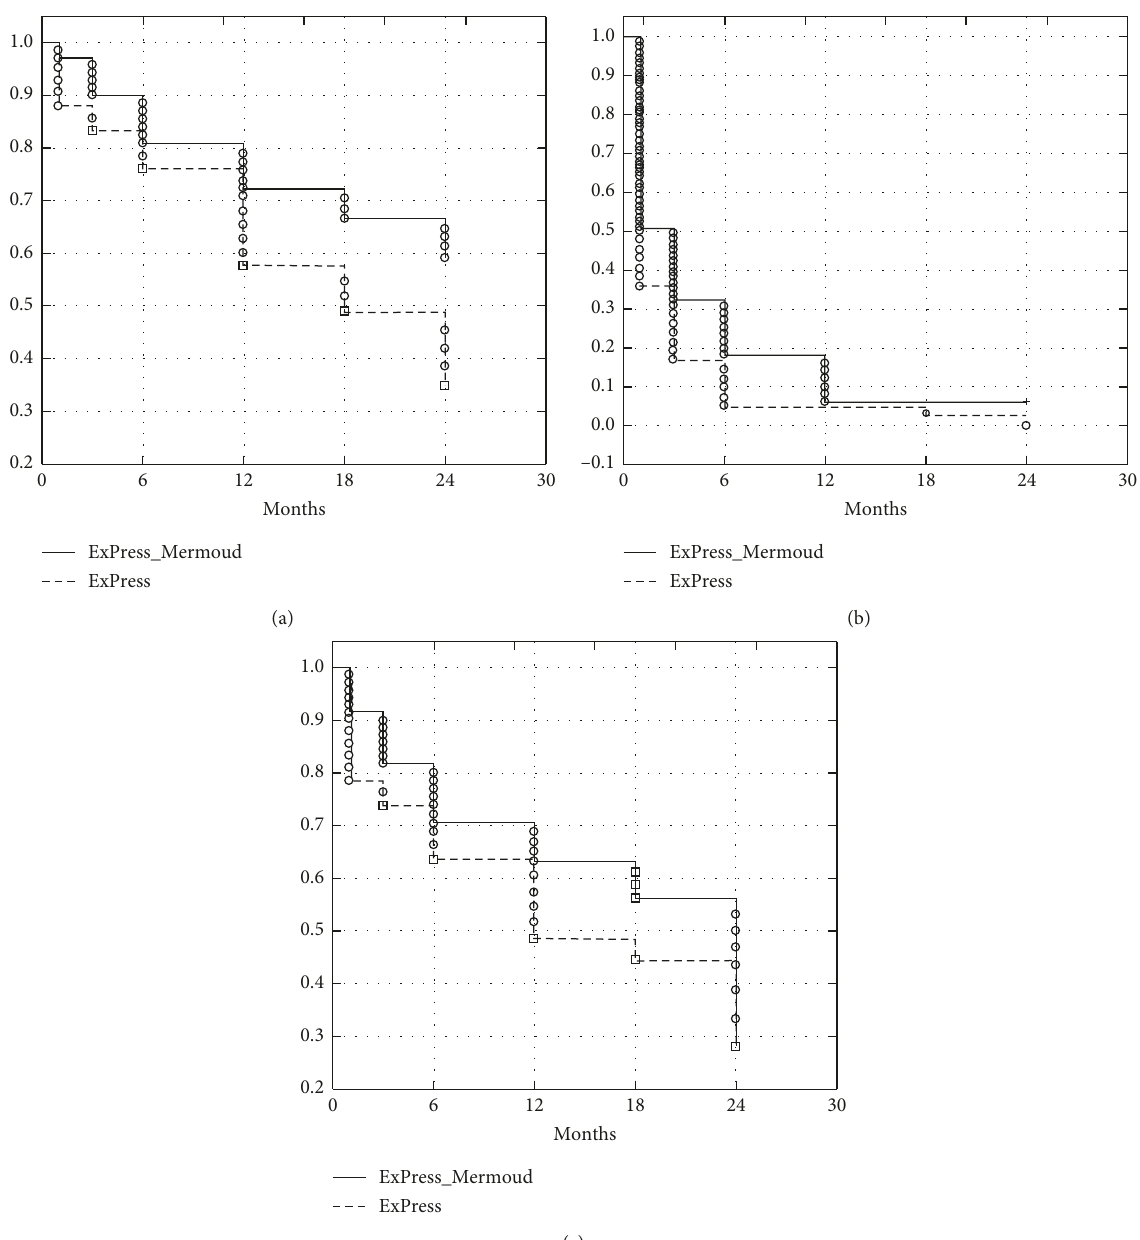
Figure 2: Cumulative survival proportion (%) (Kaplan–Meier) for the success criterion of intraocular pressure less than or equal to 18mmHg (criterion A) (a), 16 mmHg (criterion B) (b), and 12mmHg (criterion C)